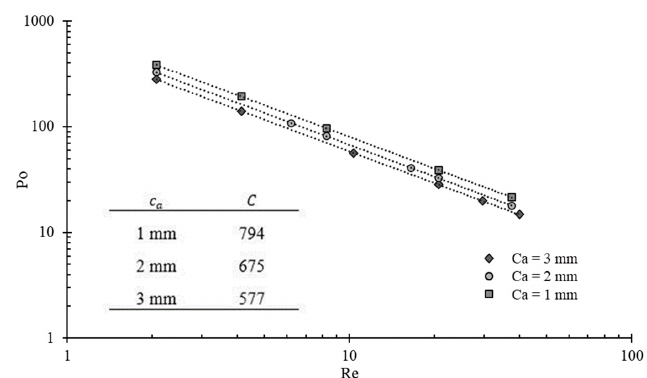
Figure 7. Numerically obtained Po-Re curve and C values for the Newtonian case.